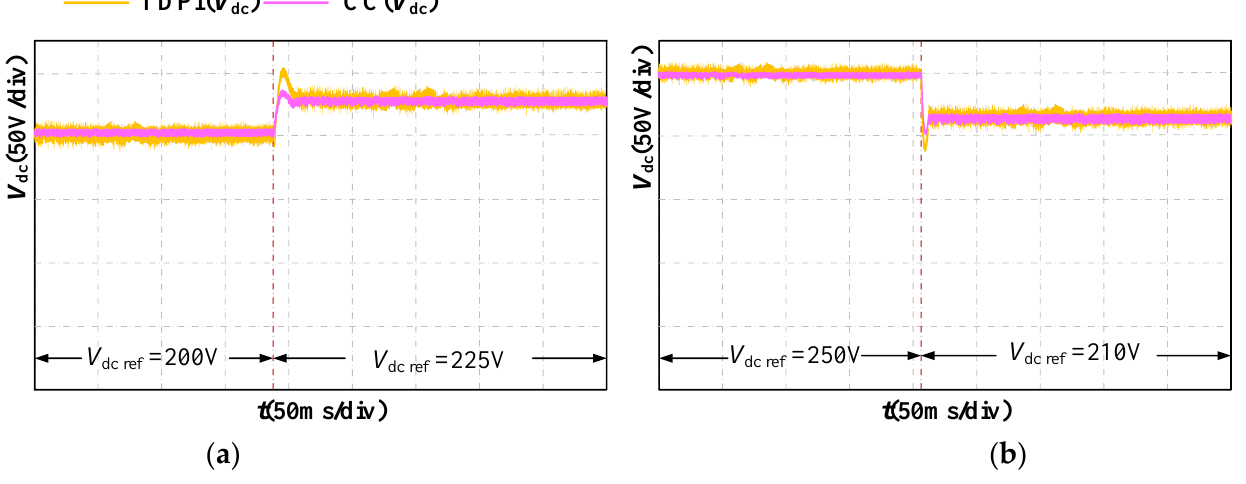
Figure 11. Experimental results for sudden change in reference voltage. ( a ) V dc ref suddenly increases to 225 V; ( b ) V dc ref suddenly decreases to 210 V.